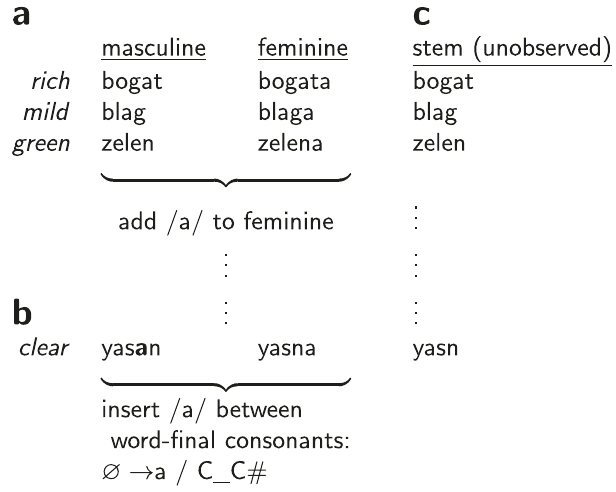
Fig. 1 | A morpho-phonology problem. a Serbo-Croatian data (simpli fi ed). This language ’ s morphology is illustrated for masculine and feminine forms. The data motivate a morphological rule which forms the feminine form by appending /a/. b illustrates a counterexample to this analysis: the masculine, feminine forms of clear are /yasan/, /yasna/. These pronunciations are explained by Serbo-Croatian phonology : the sound /a/ is inserted between pairs of consonants at the end of words, notated + ! a / C_C#. This rule requires that the true stem for /yasan/, /yasna/ is /yasn/. c shows further stems inferred for this data. These stems are stored in the lexicon